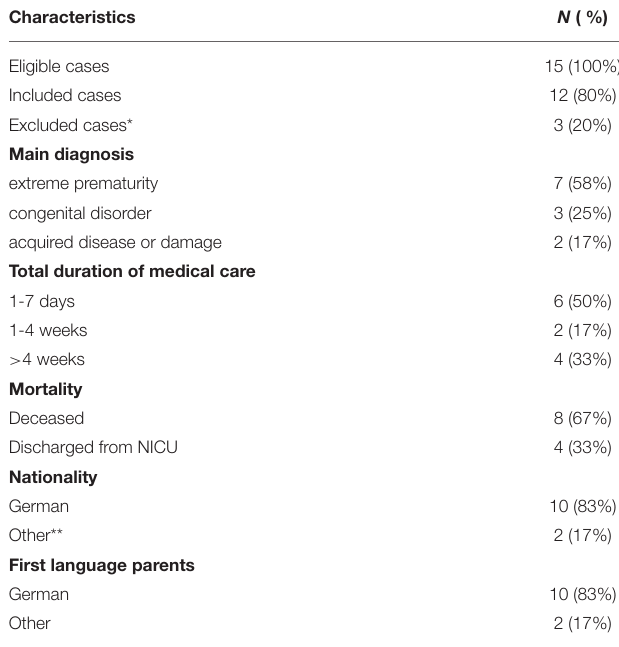
TABLE 2 | Characteristics of parents and